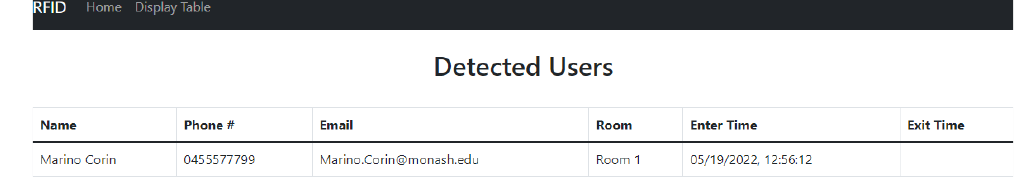
Figure 14. RFID system web interface displaying detected user after a tag was found.